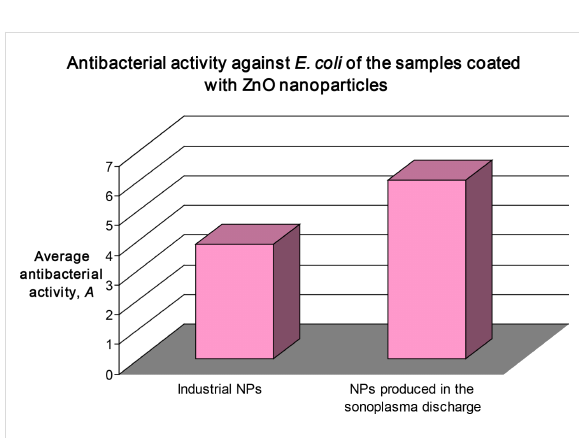
Figure 7: Antibacterial activity against E. coli of the samples coated with ZnO